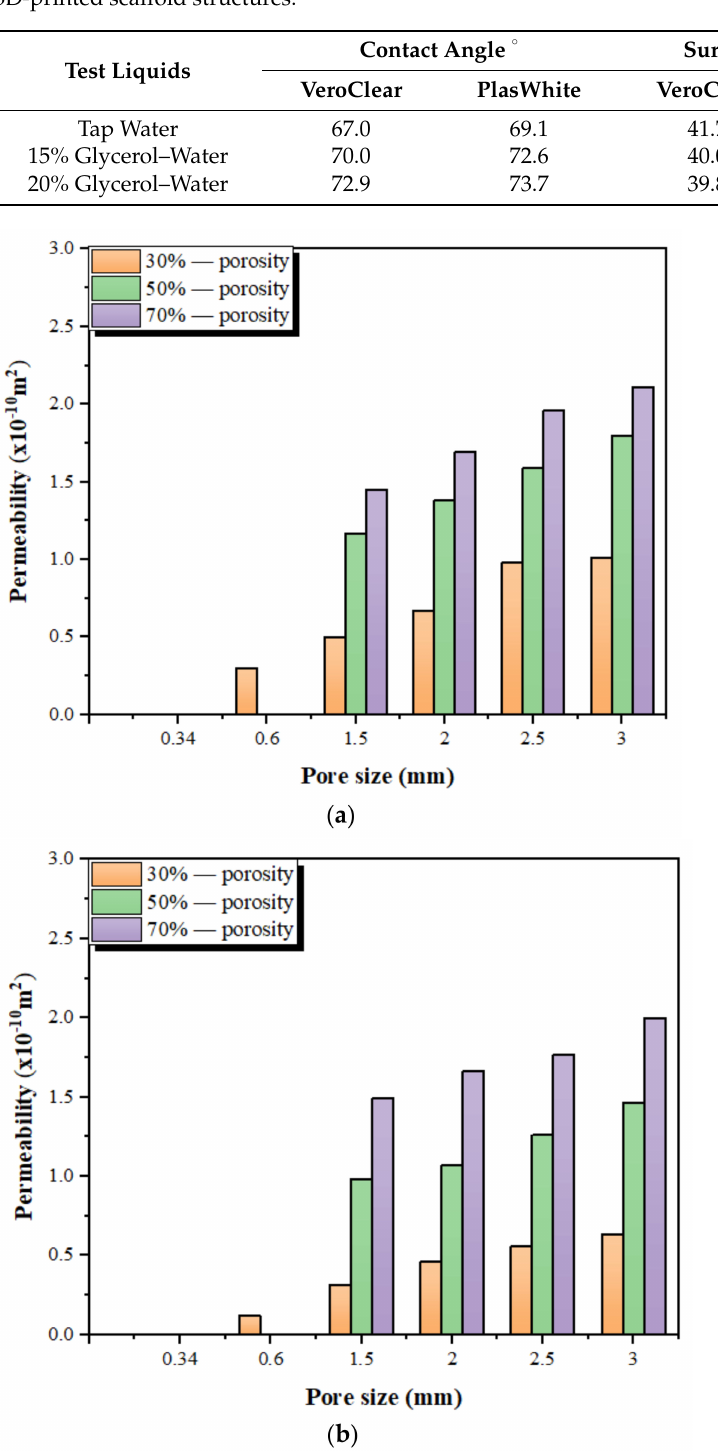
Figure 5. Numerically calculated permeability values: ( a ) Scaffold structures with cubic pore shape; ( b ) Scaffold structures with hexagonal pore